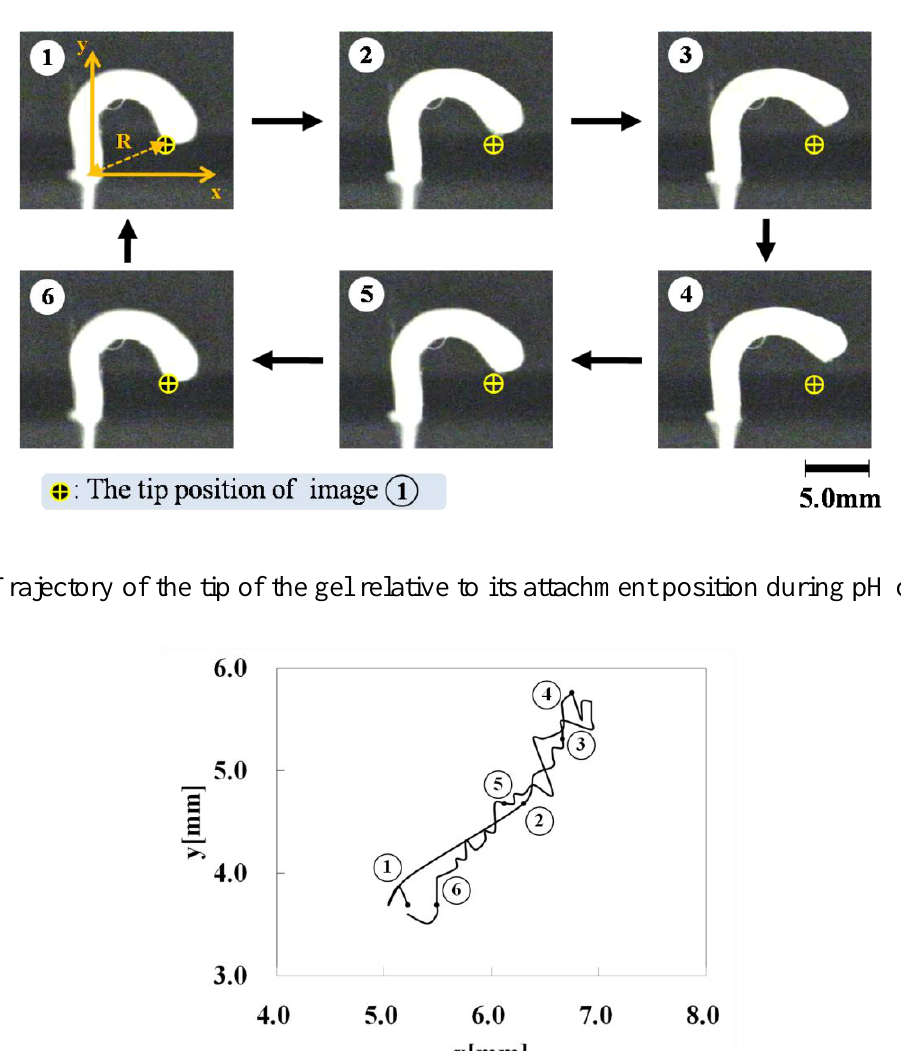
Figure 6. Periodical pendulum motion of poly(AAc- co -nBMA) nanofiber gel.